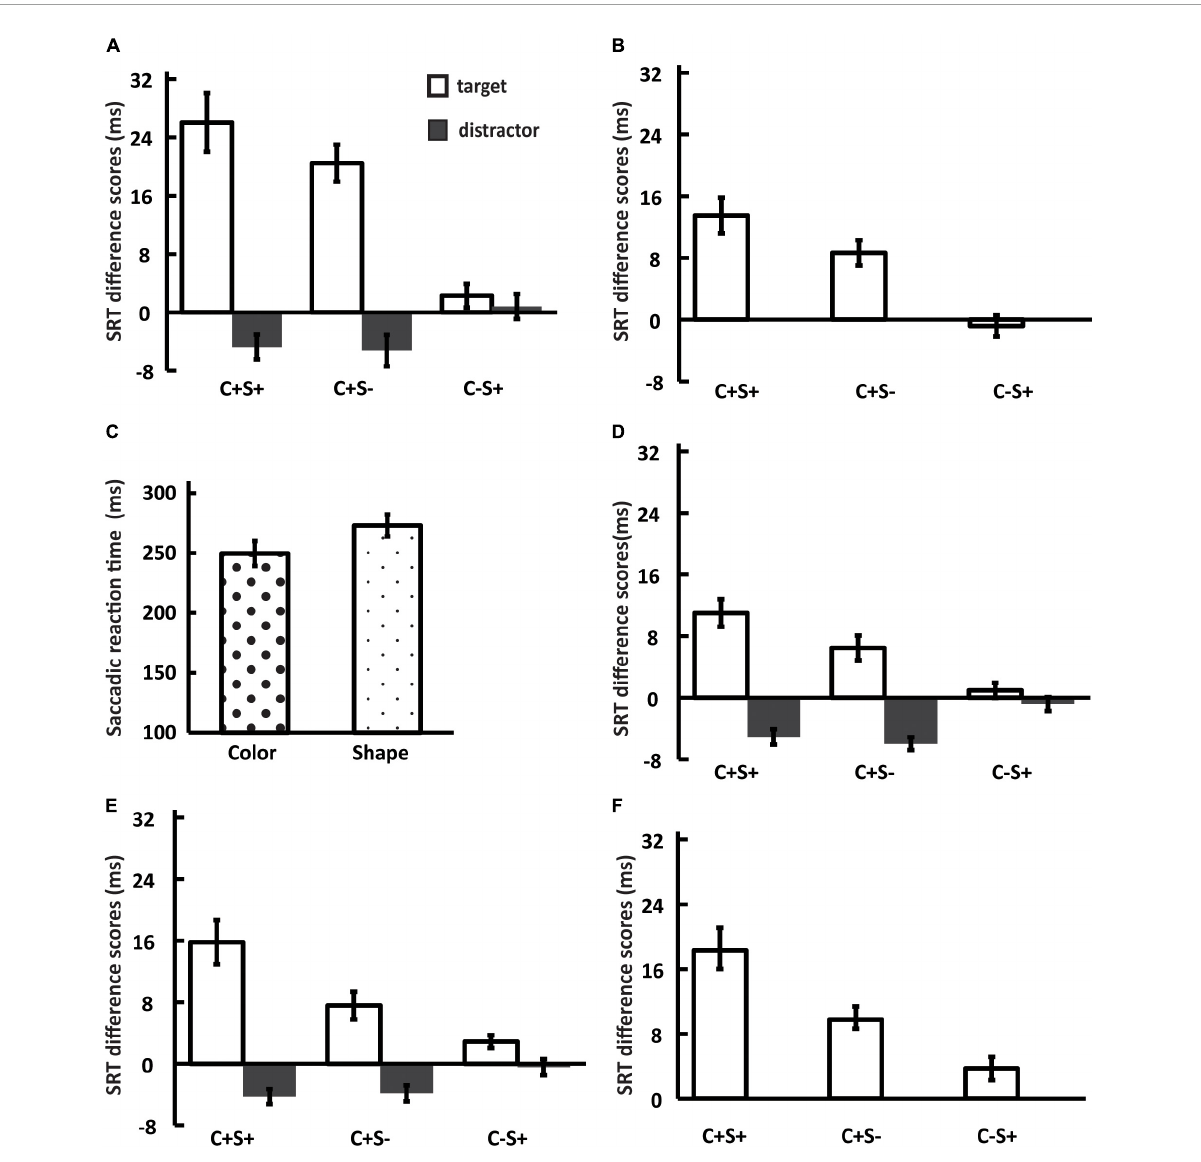
FIGURE2 Results of SRT difference scores for Experiment 1A (A) , Experiment 1B (B) , Experiment 2 (D) , Experiment 3A (E) , and Experiment 3B (F) . (C) Results of SRT for color search task and shape search task (Experiment 1C). Error bars represent standard errors of the mean across